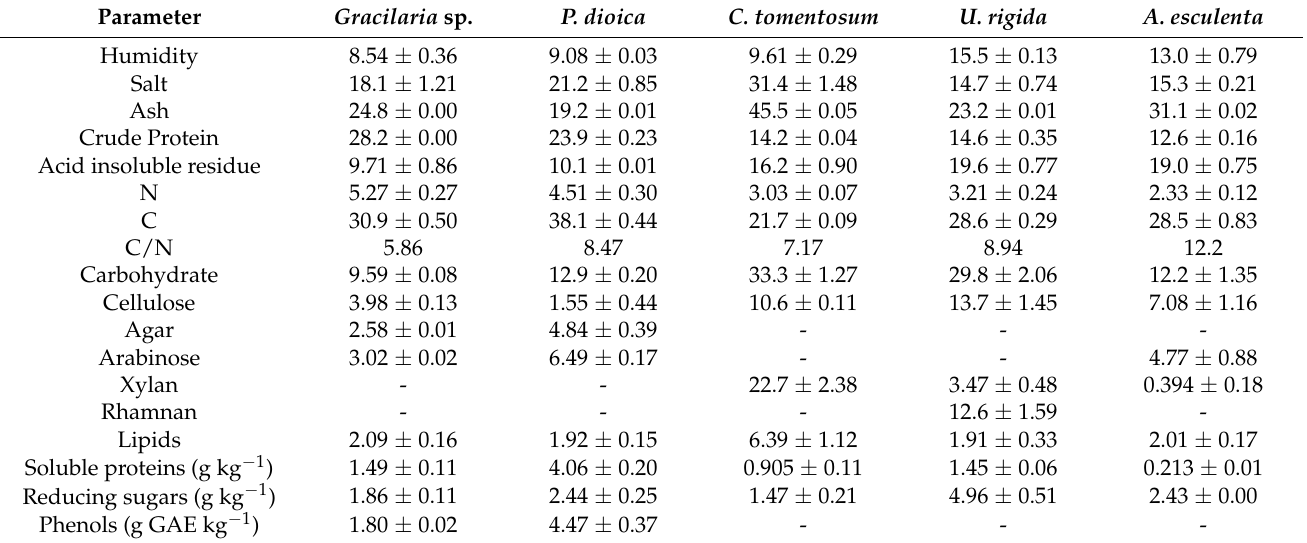
Table 1. Physicochemical composition of the different seaweeds studied (% w / w dry seaweed).